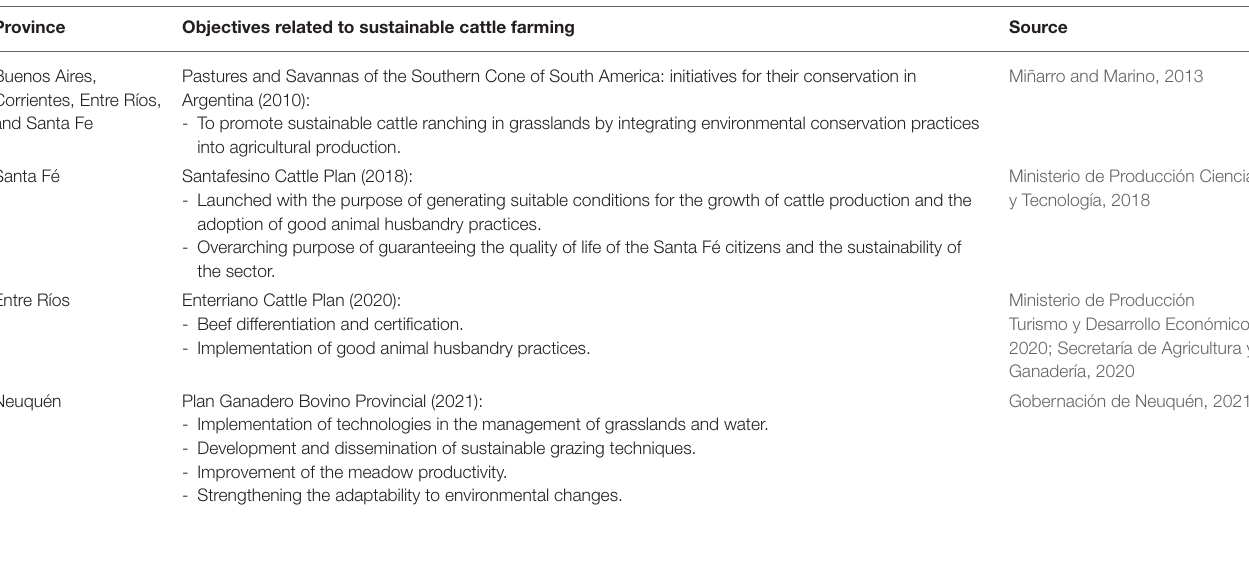
TABLE 3 | Overview on the provincial cattle plans of